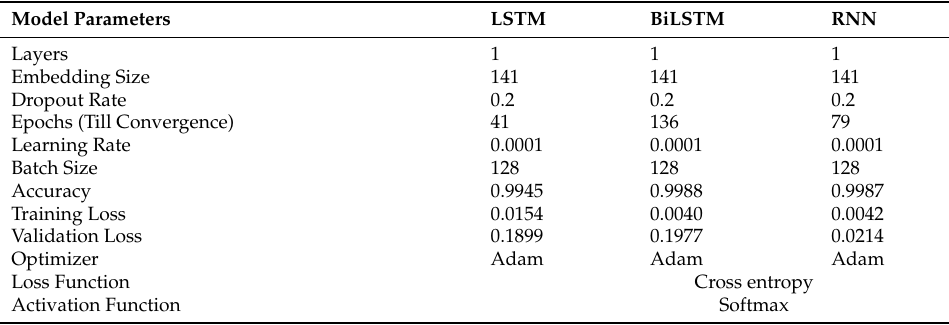
Table 4. Instantiated models parameters.